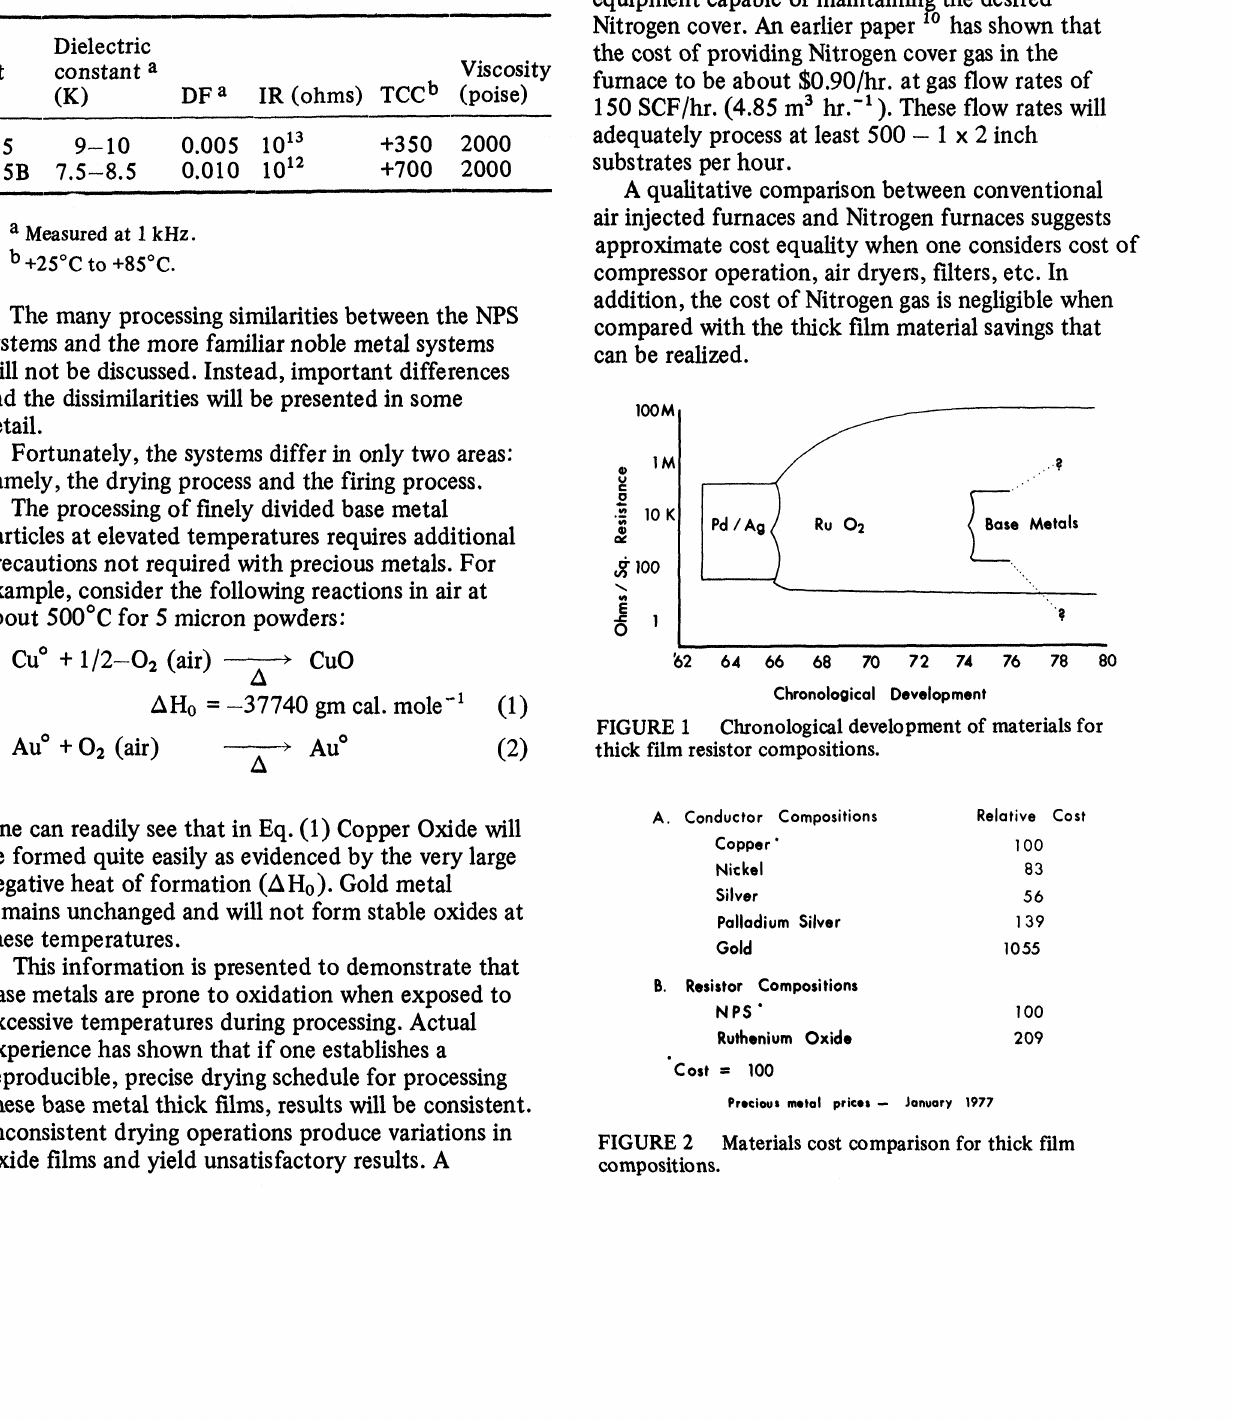
Materials cost comparison for thick film